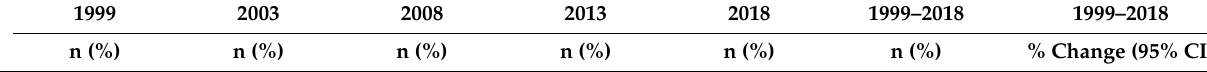
Table 1. Distribution of traditional birth attendant delivery by study factors in Nigeria,